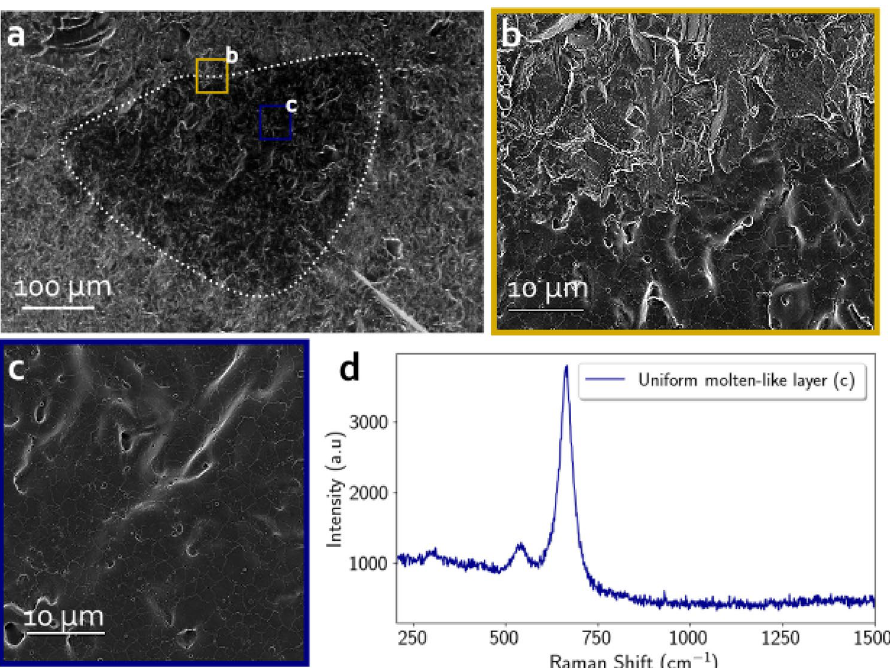
Figure 3. SEM images of the 5 shot deep crater on hematite. ( a ) Overview of the crater where its borders are visible. Locations of the two zooms depicted are represented by color squares. ( b ) Close-up view of the crater border showing a sharp transition. ( c ) Zoom on the uniform molten-like layer composing the crater floor. ( d ) Raman spectrum of pure magnetite acquired in the molten-like layer displayed in ( c